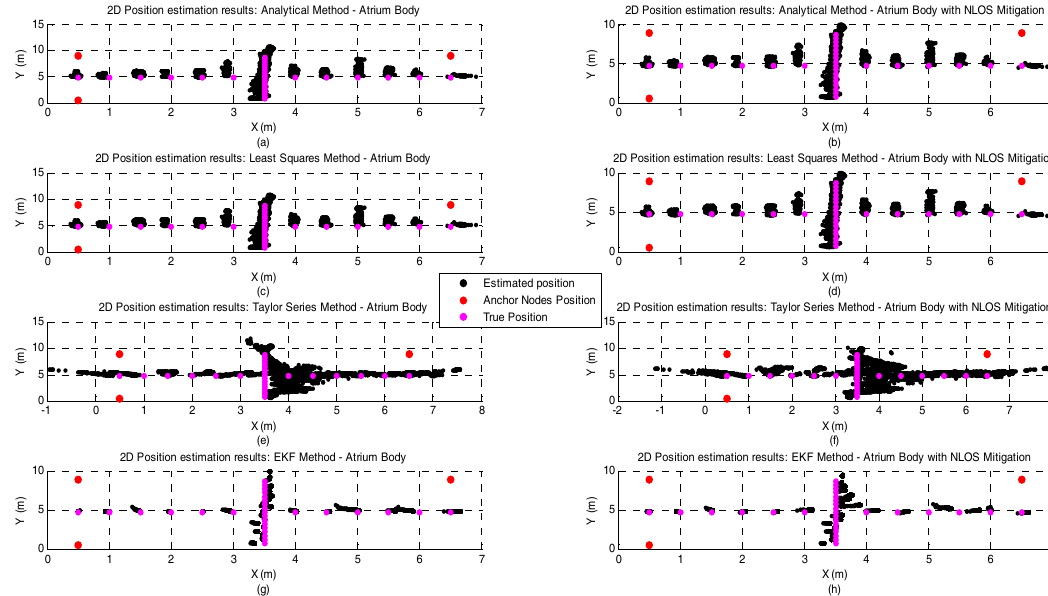
Figure 8. Graphical illustration of the 200 position estimates for each test point in the atrium scenario, with human body interference, and with or without NLOS mitigation. The plots on the left side of the figure represent the position estimates without NLOS mitigation and the plots on the right the position estimates with NLOS mitigation. Each row represents the results obtained by each positioning algorithm and their order from the top to the bottom of the figure is: Analytical method —( a , b ); Least Squares method—( c , d ); Taylor Series method—( e , f ); and EKF Method—( g , h ).